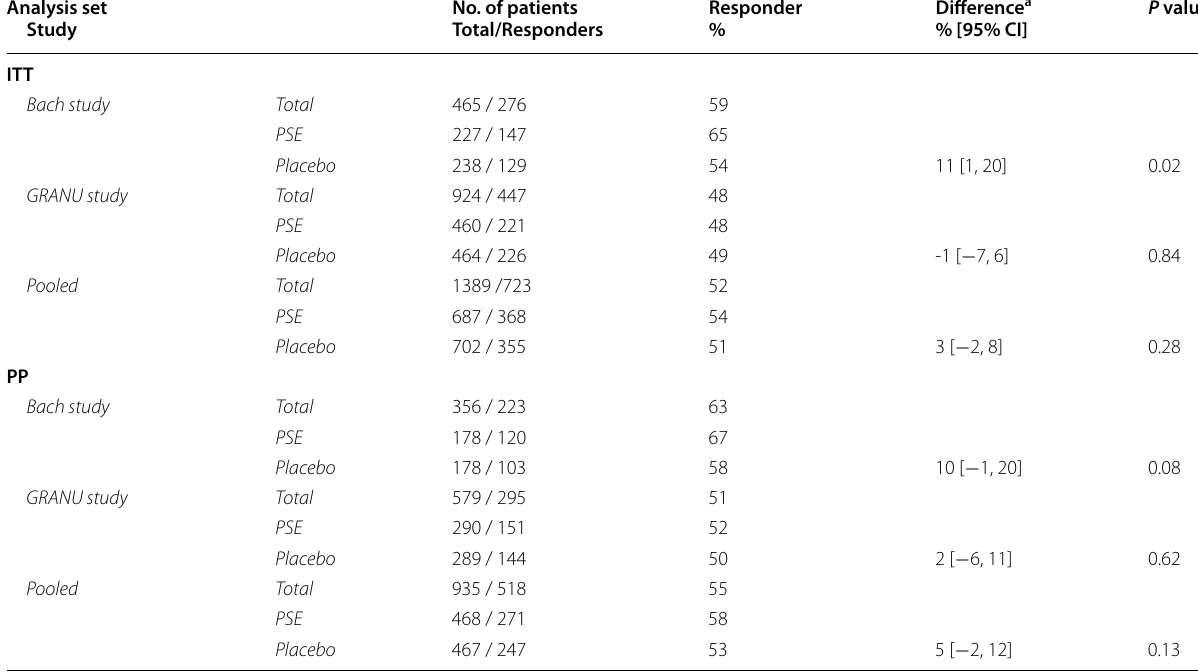
Table 4 Responders after 12 months of treatment and differences between